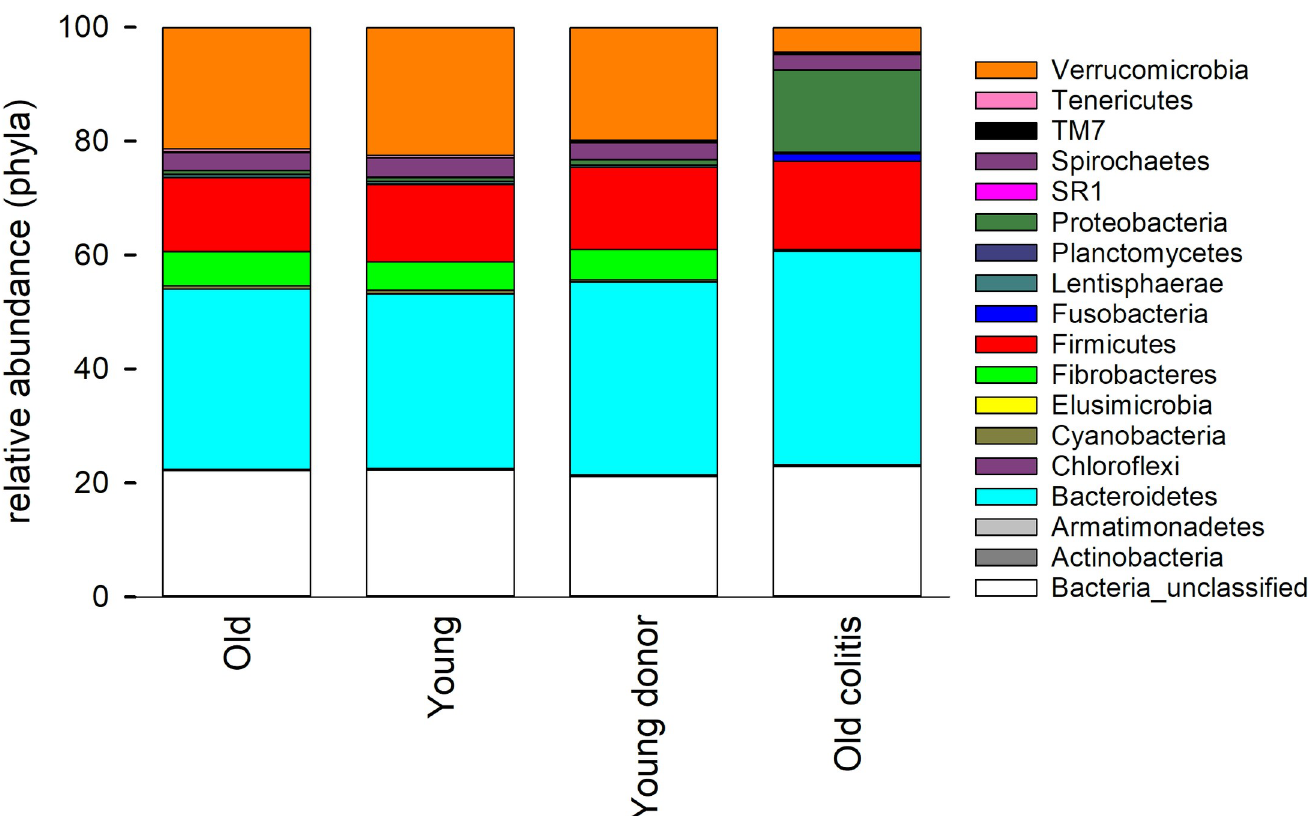
Fig 2. Mean phylum-level phylogeny of the fecal microbiota of healthy and diarrheic horses. Stacked bars represent average relative phyla abundance in the fecal microbiota of 30 healthy old-horse samples, 30 healthy young-horse samples (15 horses collected at two time-points in each age-group), 15 samples from 3 young FMT donor horses (age range: 6–12 years), two technical replicates and 20 samples from 5 geriatric horses with colitis.